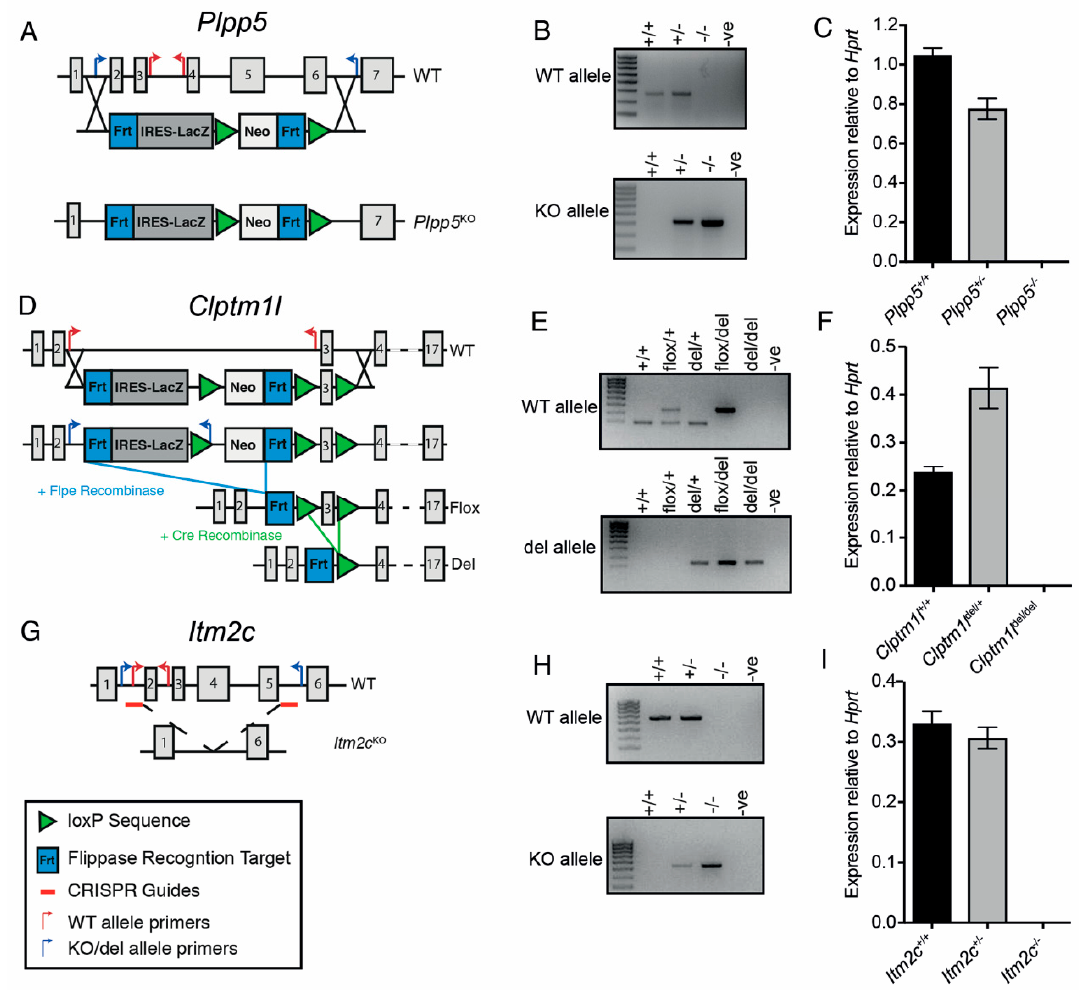
Figure 5. Generation of Plpp5 , Clptm1l and Itm2c deficient mouse models . ( A ) Strategy for the generation of the non-functional ( − ) Plpp5 allele; ( B ) gel electrophoresis of PCR products amplified from WT, Plpp5 +/ − and Plpp5 − / − pups. –ve, negative control water only; ( C ) mRNA expression of Plpp5 in WT, Plpp5 +/ − and Plpp5 − / − B cell cultures following 4 days of LPS stimulation; ( D ) strategy for the generation of the conditional (flox) and non-functional (del) Clptm1l alleles; ( E ) gel electrophoresis of PCR products amplified from WT, Clptm1l flox/+ , Clptm1l del/+ , Clptm1l flox/del and Clptm1l del/del pups; ( F ) mRNA expression of Clptm1l in WT, Clptm1l del/+ and Clptm1l del/del B cell cultures following 4 days of